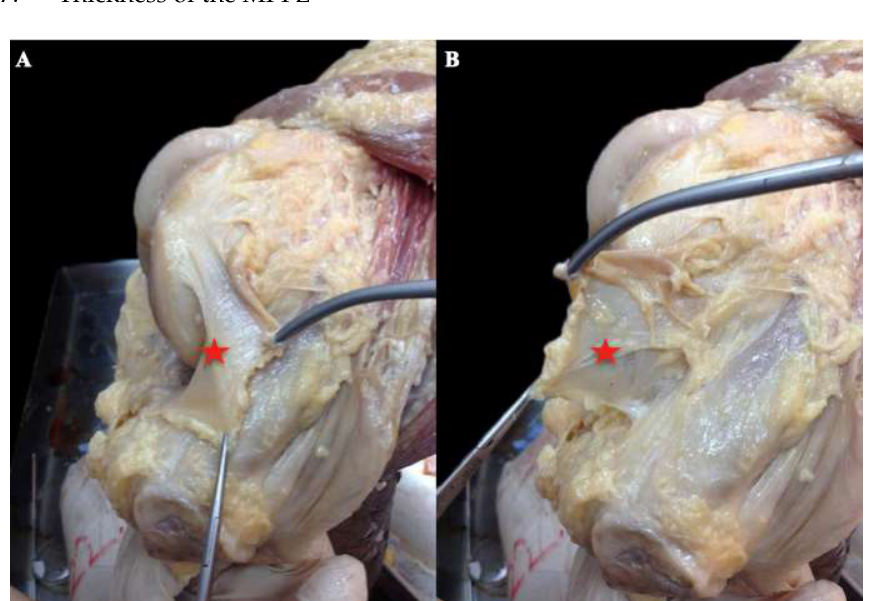
Figure 1. ( A , B ): Cadaveric right knee, medial side. The patella has been reflected medially. The capsule (red star) is detached from the second layer.